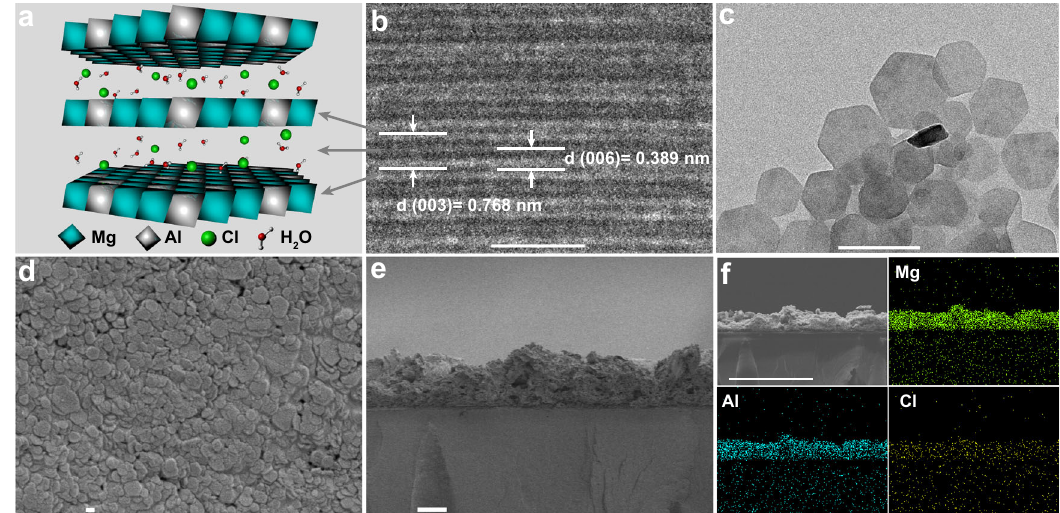
Fig. 2 Layered double hydroxide composite membranes. a Schematic structure of MgAl-Cl-LDH. b Environmental transmission electron microscopy (ETEM) image and c TEM image of MgAl-Cl-LDH nanosheets. d The surface morphology and e cross-section morphology of LDHs-based membrane. f The corresponding energy dispersion spectroscopy (EDS) analysis of its elemental distribution on LDHs fl ake layer. Scale bars for b , c , d , e , and f are 2 nm, 200 nm, 100 nm, 10 μ m, and 60 μ m,